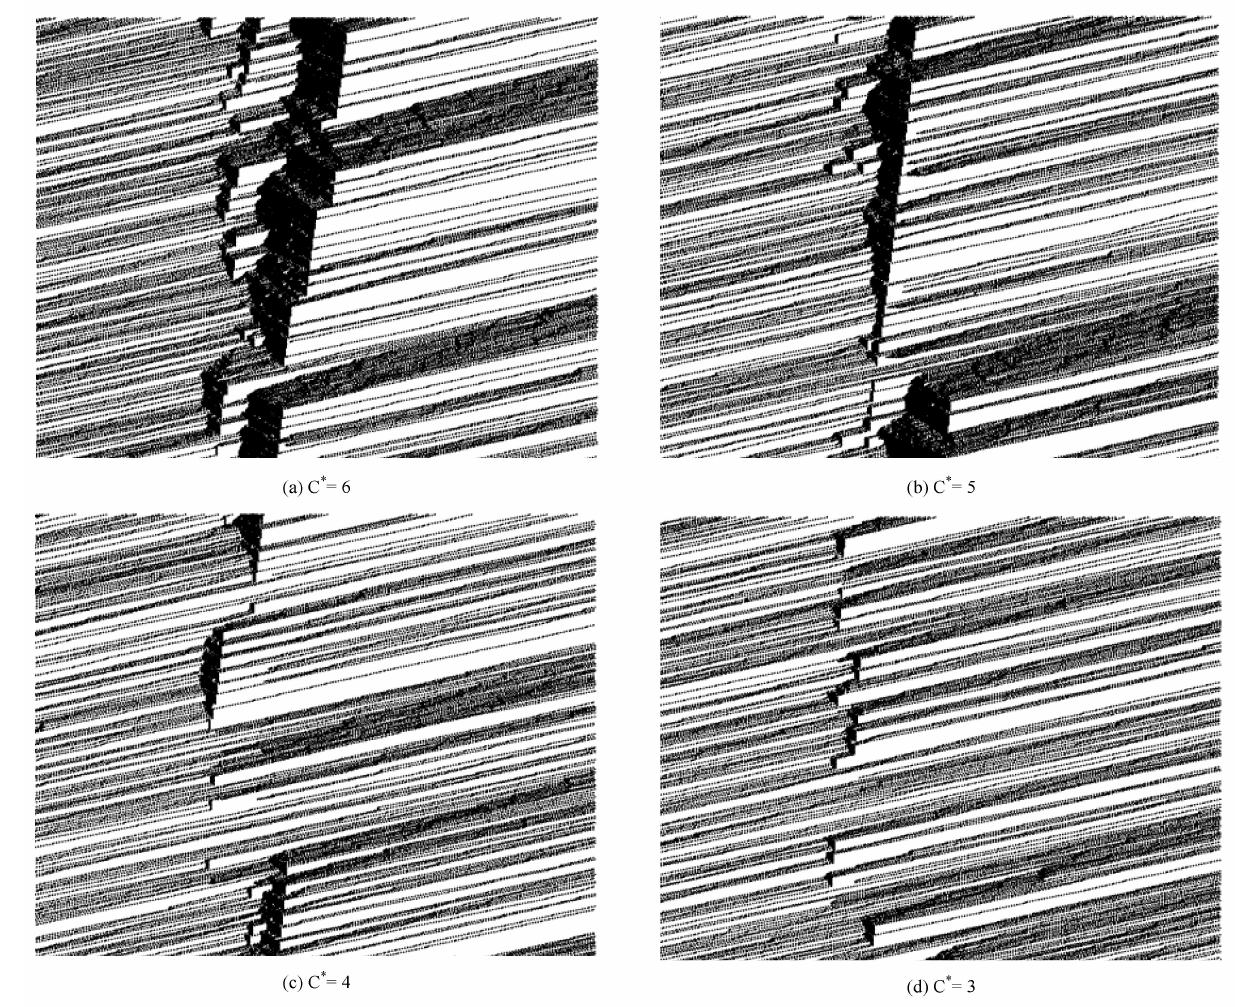
Figure 5. Time-space trajectories in four scenarios of c ∗